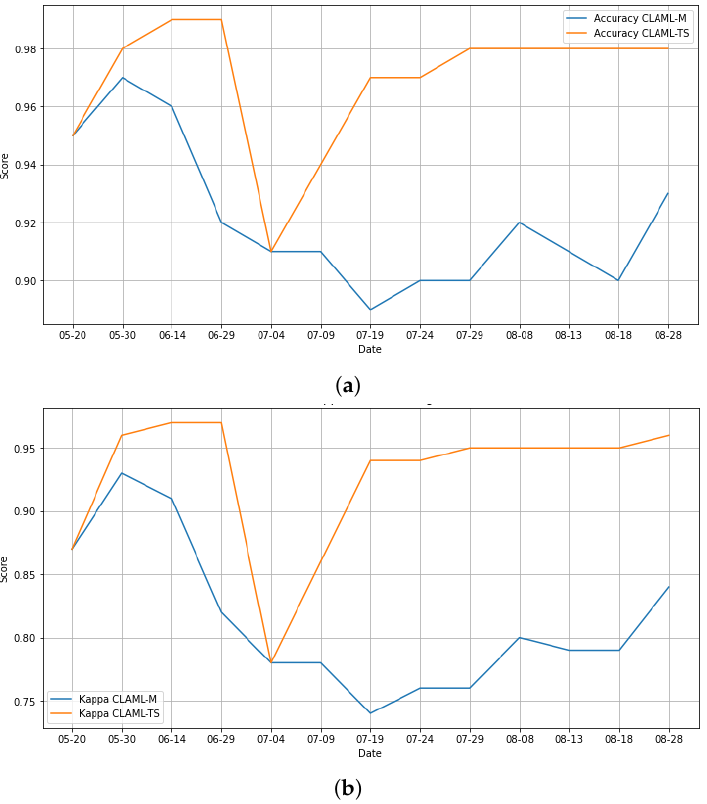
Figure 5. Metrics scoring. ( a ) Accuracy metric scoring. ( b ) Kappa metric